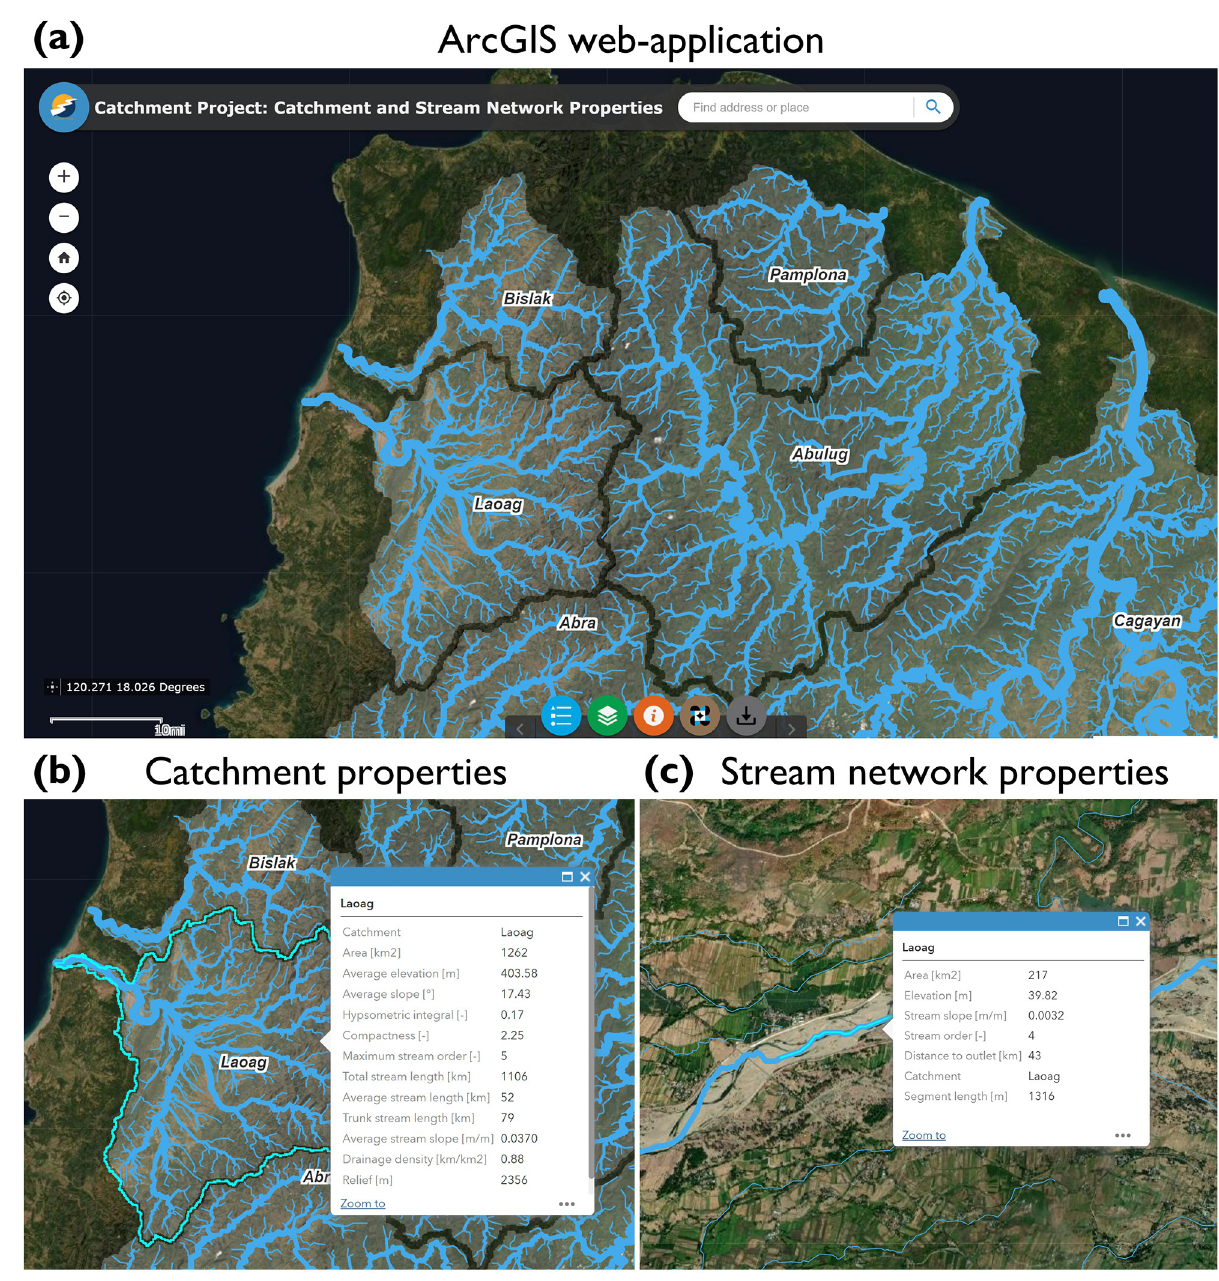
Fig 2. (a) Examples of Philippine river catchments and stream networks displayed in the ArcGIS web-application (basemap from Esri). Attributes of the Laoag catchment (Luzon Island) showing: (b) catchment properties and (c) stream network properties.